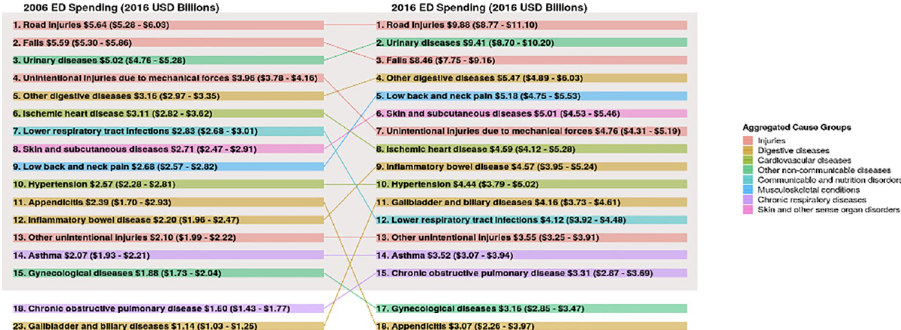
Fig 3. Arrow diagram summarizing the 15 individual health conditions with highest estimated emergency department spending levels in 2006 and 2016. Note : Health conditions are ranked by estimated ED spending in both 2006 and 2016 (both using 2016 USD) and placement in the ranking is illustrated in the arrow diagram. Each of the 154 health conditions captured by the Disease Expenditure Project (DEX) map to 1 of 15 aggregated cause groups (or referred to as 15 aggregated health categories), which are shown in the legend and displayed in Fig 1. Of note, ED spending estimates were mapped to only 150 of the 154 DEX conditions, as four health conditions (larynx cancer, well newborn care, well dental, and well person) either did not appear in the ED data or were systematically excluded as a primary diagnosis.